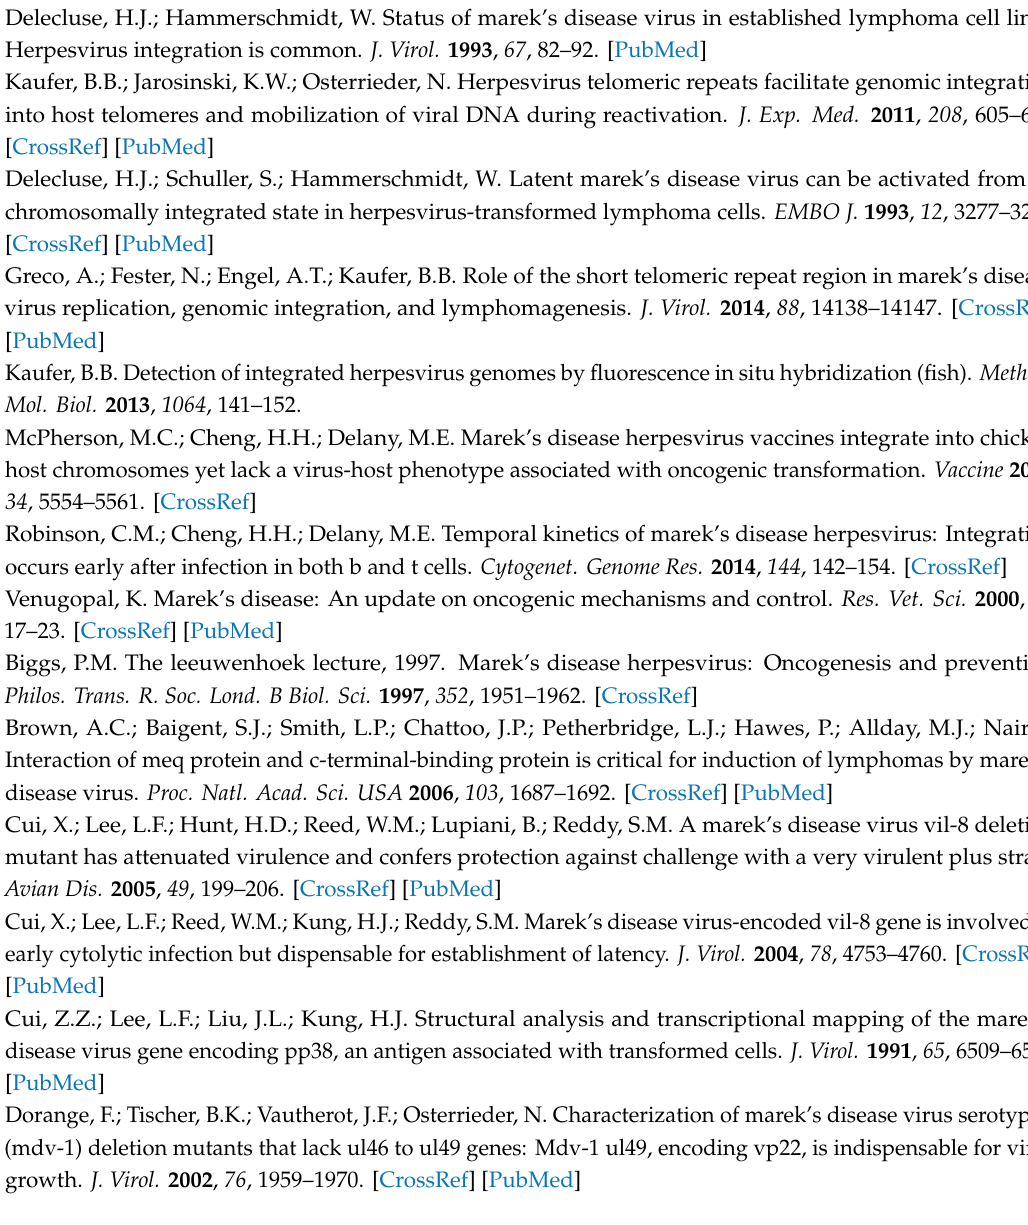
Figure S1: Induction of pp38 gene expression by AZA treatment in pp38 deleted and un-edited HP8